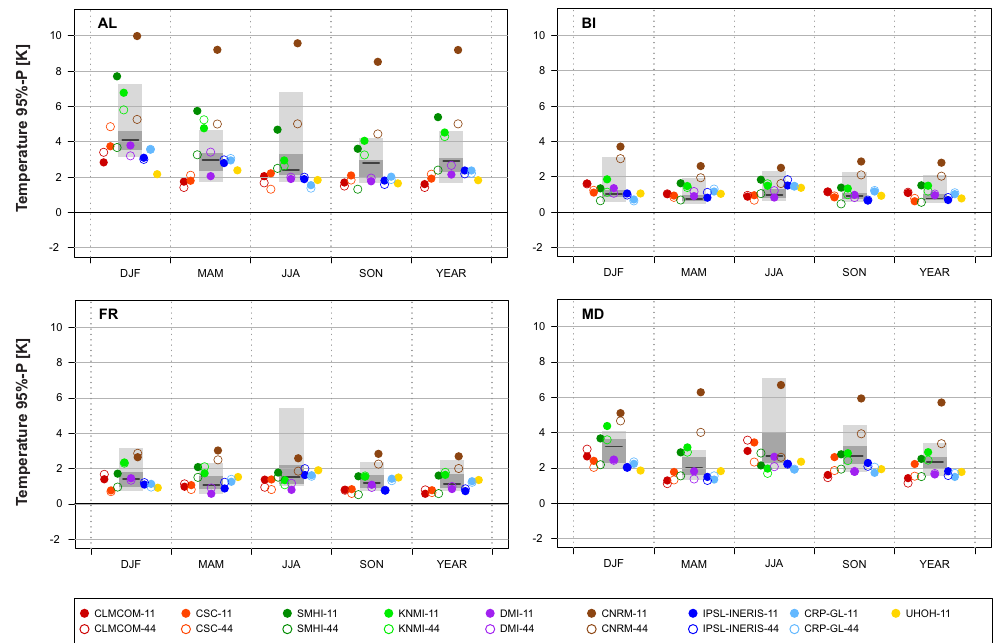
Figure B3. 95th percentile of mean seasonal and annual absolute temperature biases (95%-P; K) for the EUR-11 (filled circles) and the EUR-44 ensemble (open circles) and for subdomains AL, BI, FR and MD (see Fig. 7 for subdomains EA, IP, ME and SC). The gray bars denote the 95%-P range of the ENS-22 ensemble: entire range in light gray, interquartile range (corresponding to eight models) in dark gray and median as solid